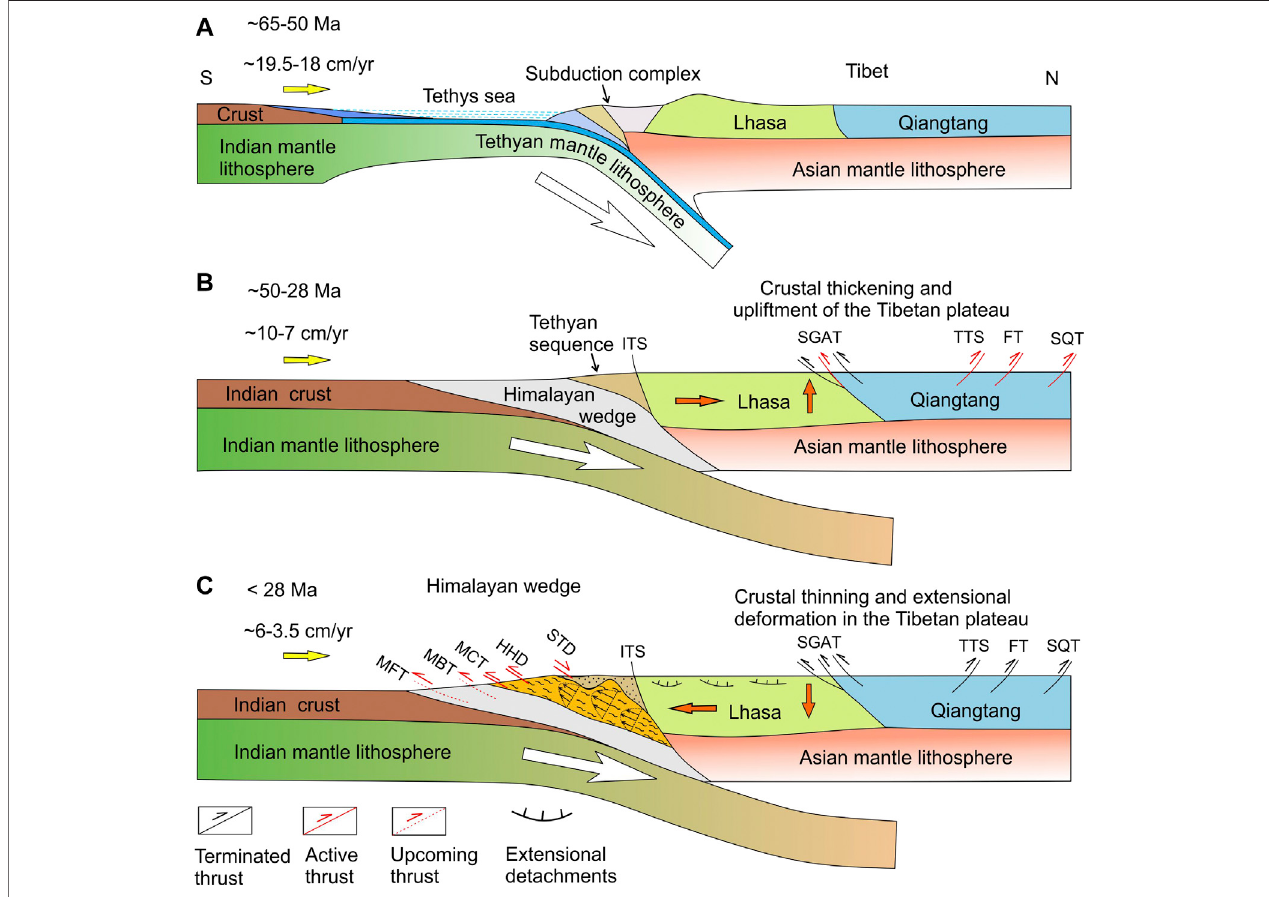
FIGURE 10 | A schematic presentation of the tectonic evolution in the India-Asia collision system (after Wang et al., 2014; Li et al., 2015). (A) Subduction of the Tethyan lithosphere against the Asian continental plate. (B) Disappearance of the Tethys sea and development of the India-Asia continental contact. At this stage, the Himalayan wedge started to grow along with the upliftment of the Tibetan plateau. (C) Collapse of the Tibetan plateau and initiation of extrusion zone in the Himalayan wedge. Bold orange arrows show crustal- fl ow directions. ITS, indus tsangpo suture zone; FT, fenghuo shan – nangqian thrust belt; MBT, main boundary thrust; MCT, main central thrust; MFT, main frontal thrust; SGAT, shiquanhe – gaize – amdo thrust belt; STD, south tibetan detachment systems; SQT, Southern Qaidam thrust belt; TTS, Tanggula Shan thrust belt.